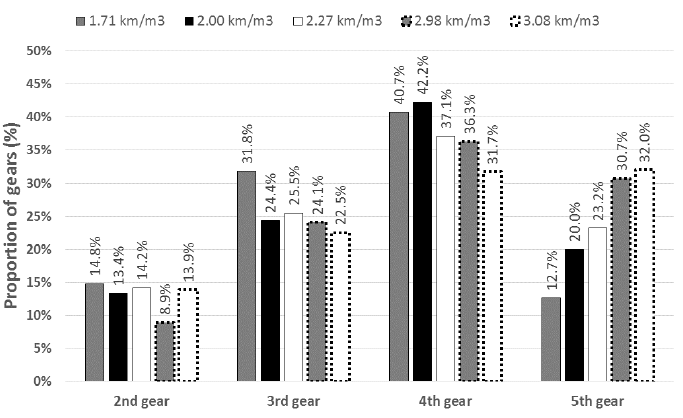
Figure 3. Proportion of gears by fuel economy of buses.